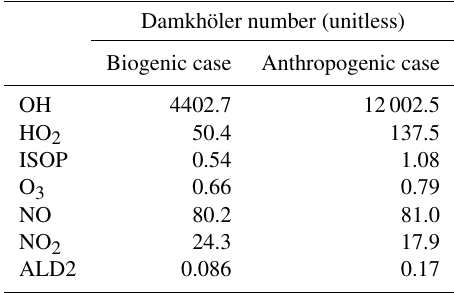
Table 4. Simulated Damkhöler number of chemical species aver- aged from the surface to 0.6km at 12:00UTC for the two cases calculated with τ turb ≈